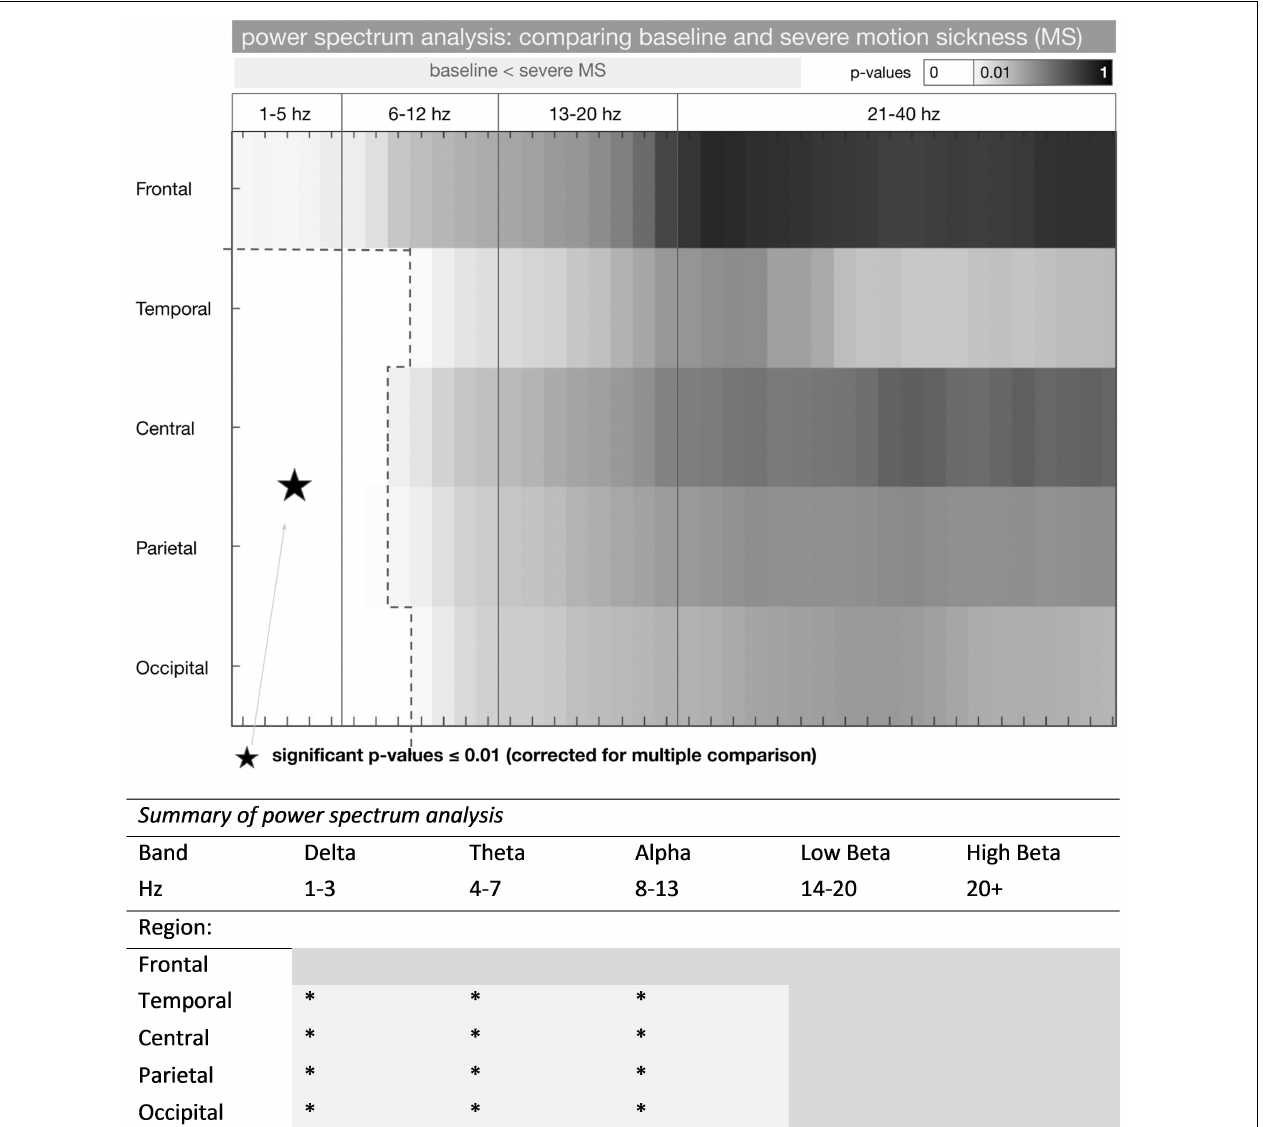
FIGURE 2 | Power spectrum analysis in baseline and severe motion sickness EEG. * represents a significant increase in frequency power (baseline < severe MS) ( p < 0.01). P -values of comparing the standardized mean (mean / standard deviation) of the power spectrum in the baseline and the severe motion sickness EEG are shown ( n = 14 participants). P -values were considered significant at p ≤ 0.01 (corrected for multiple comparisons); these frequencies are shown in white. Power spectra for F3/F4, T7/8, P3/P4, and O1/O2 were averaged to frontal, temporal, parietal, and occipital (rows). The frequency separation to 1–5, 6–12, 13–20, and 21–40 Hz derived from a SOM with 2 × 2 groups. A more detailed presentation of these results is shown in Supplementary Figure 1